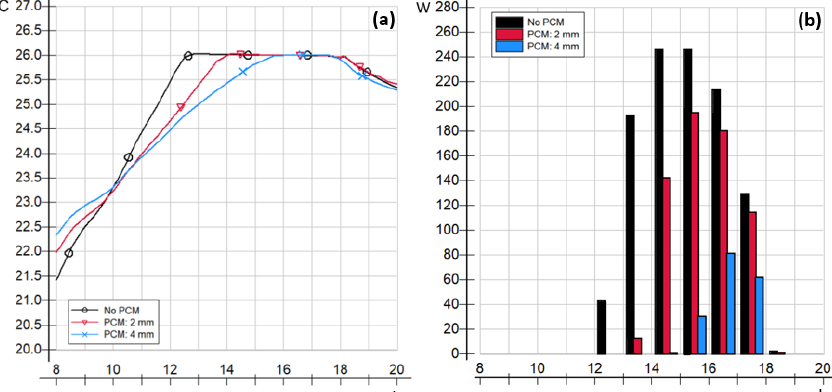
Figure 8. Cooling load reduction for a representative cubicle on a typical day. Case: Hybrid NV, 3 ACH. ( a ) Operative temperature development. ( b ) Hourly average mechanical cooling